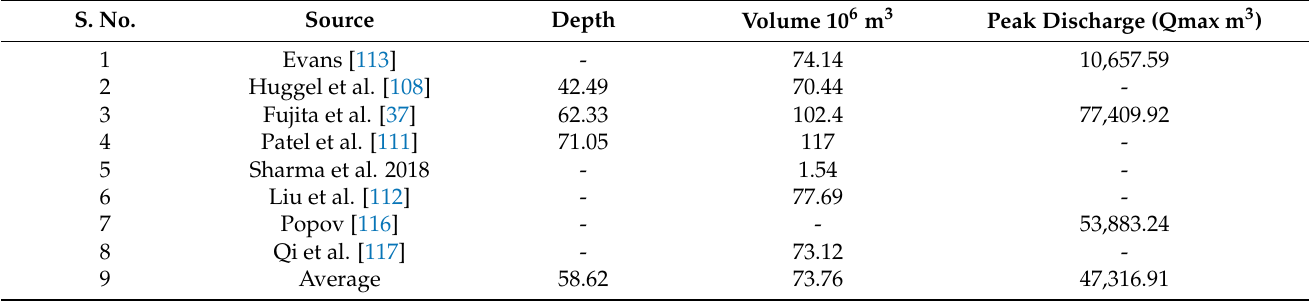
Table 5. Results (depth, volume, and peak discharge) are derived from different empirical